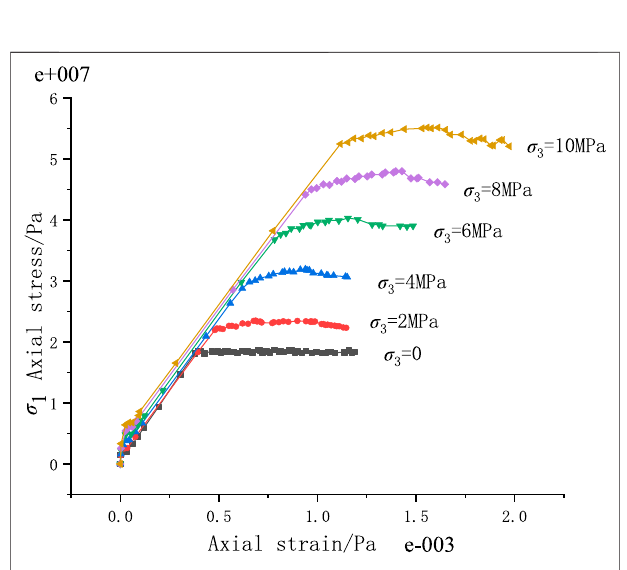
FIGURE 3 | Axial stress – strain curves of the intact rock under different con fi ning pressures.